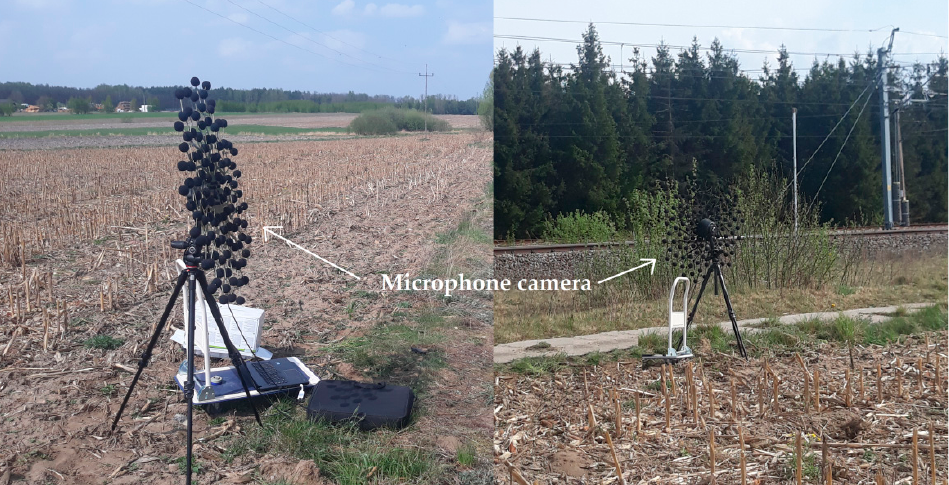
Figure 5. Microphone camera Noise Inspector Bionic M-112.